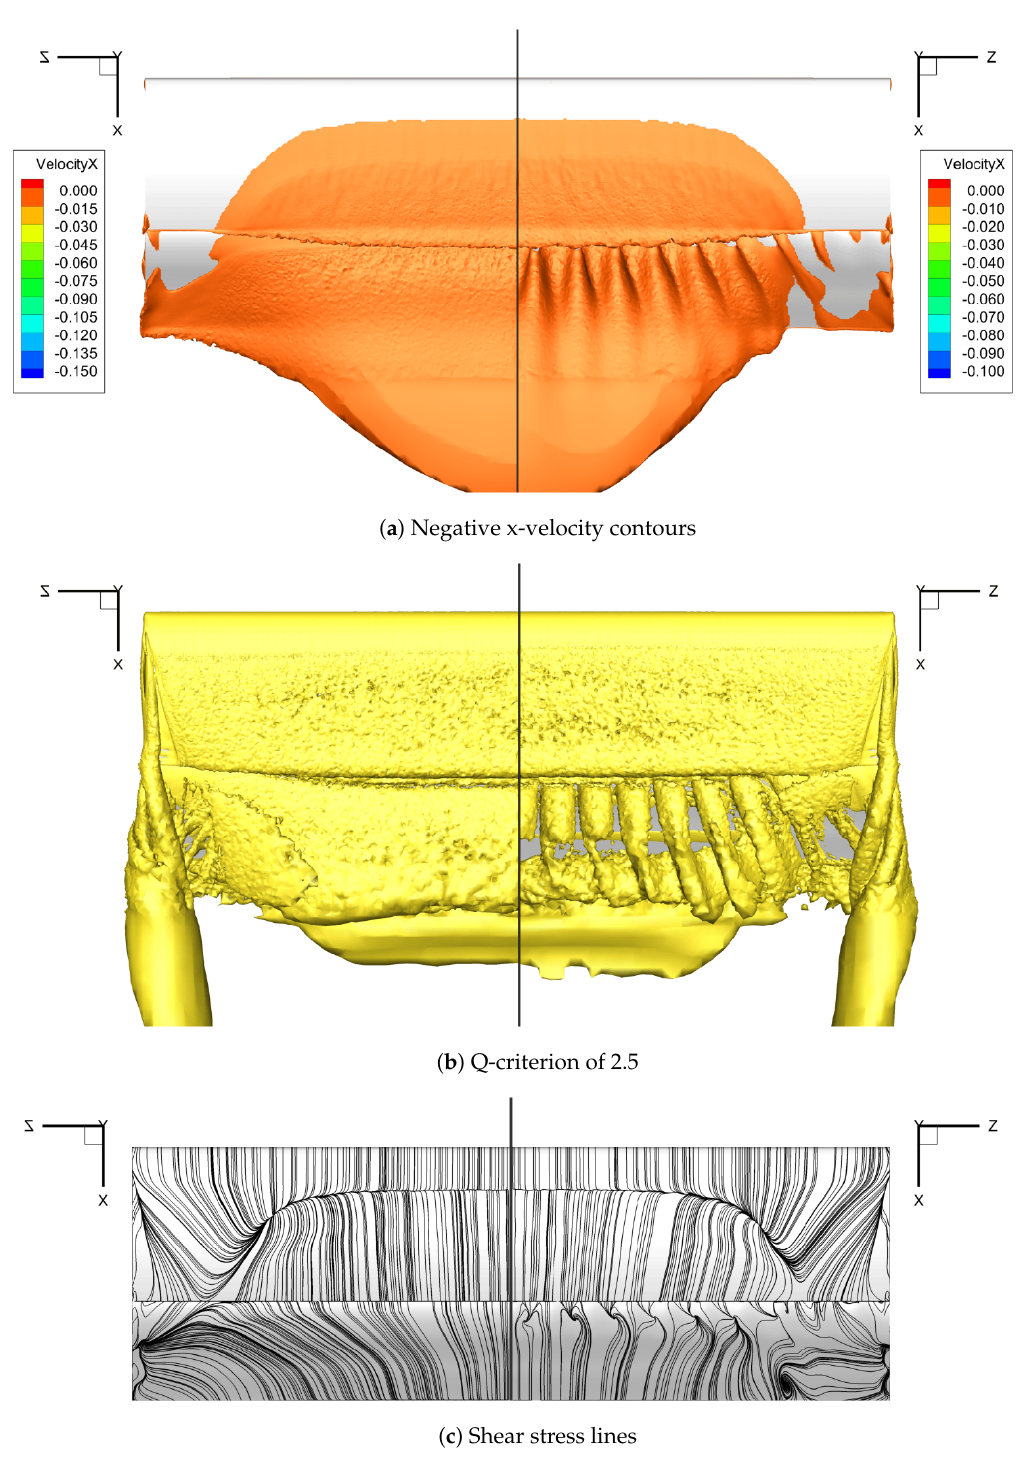
Figure 11. Comparison between the baseline (left) and F Tubercles (10 tubercles/2 A = 0.05 c ) (right) geometries. The geometries are seen from below and slightly from behind. The main element is at the top and the flap at the bottom. The flow is going from the top to the